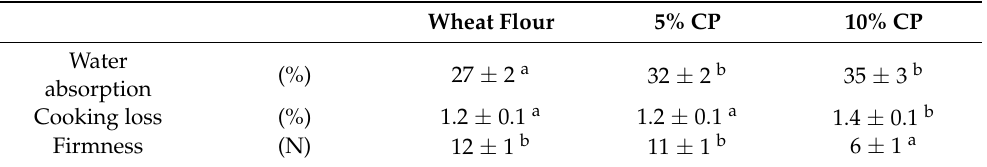
Table 2. Water absorption, cooking loss, and firmness of “tagliatelle” prepared from wheat flour alone, and with increasing replacement level of cricket powder (5% and 10%